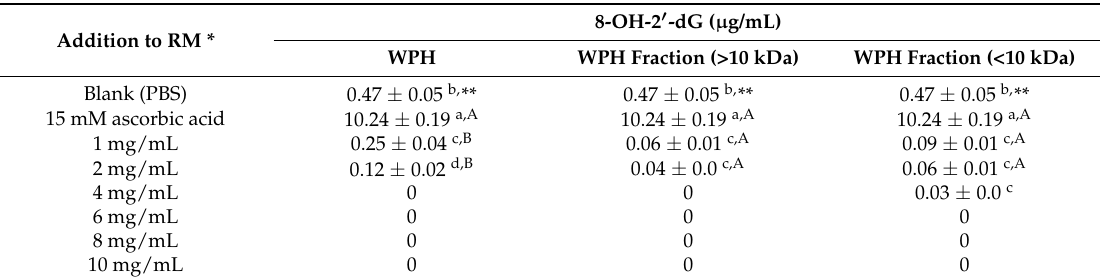
Table 1. Effect of WPH and WPH fractions on the oxidation of 2 ′ -dG to 8-OH-2 ′ -dG induced by Fenton reaction.